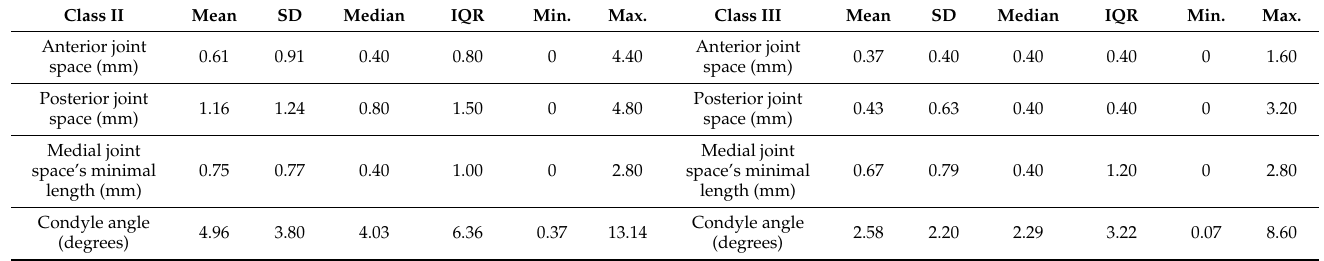
Table 3. The change values between T0–T1 moments ( n = 28, absolute value).